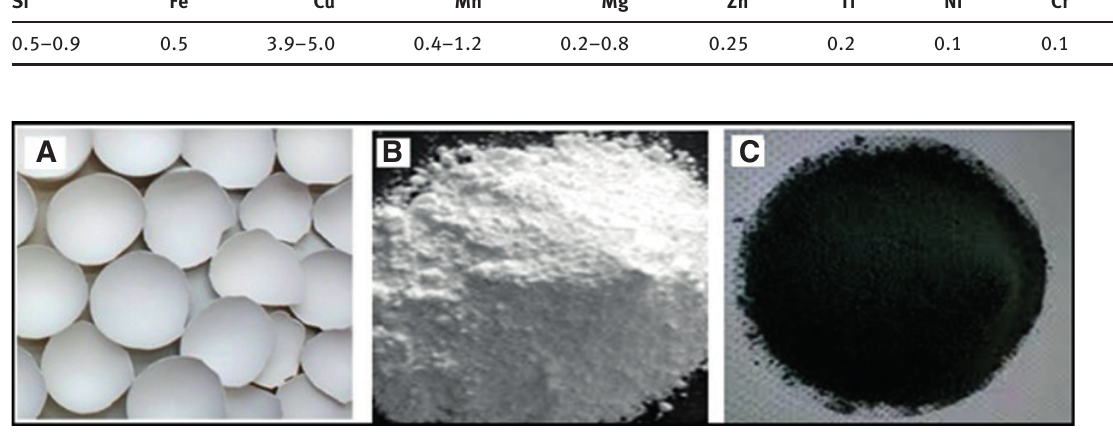
Figure 1: Photographs of: (A) eggshells, (B) eggshell powder, (C) carbonized eggshell